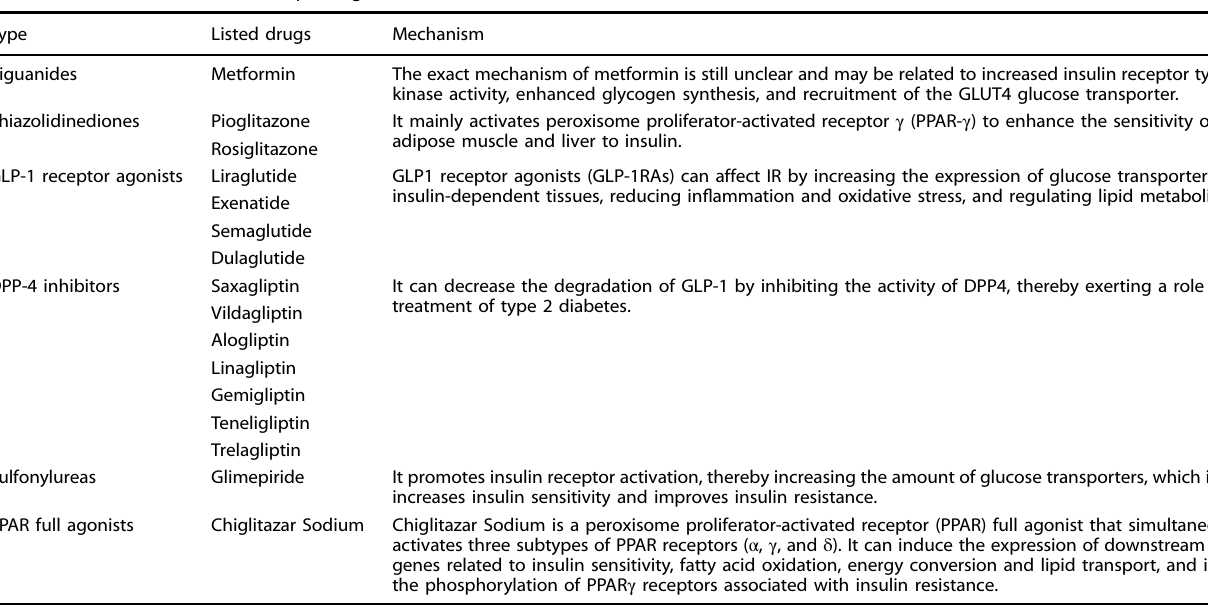
Table 1. Clinical medication for improving insulin